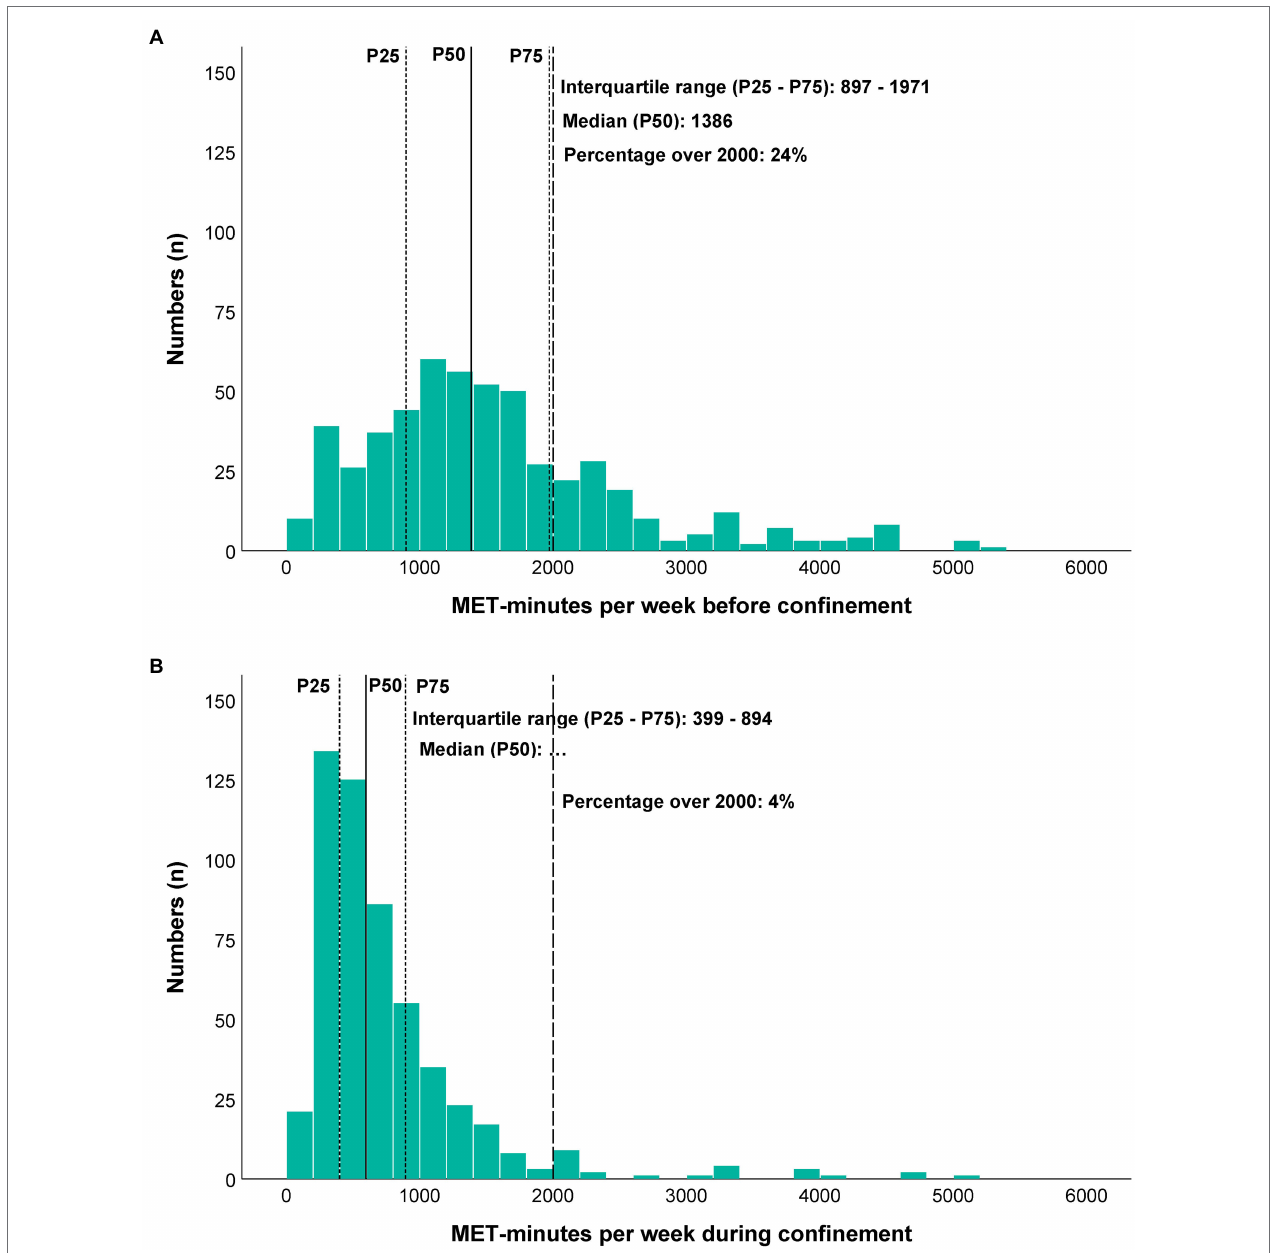
FIGURE 1 | Energy consumption before (A) and during (B)